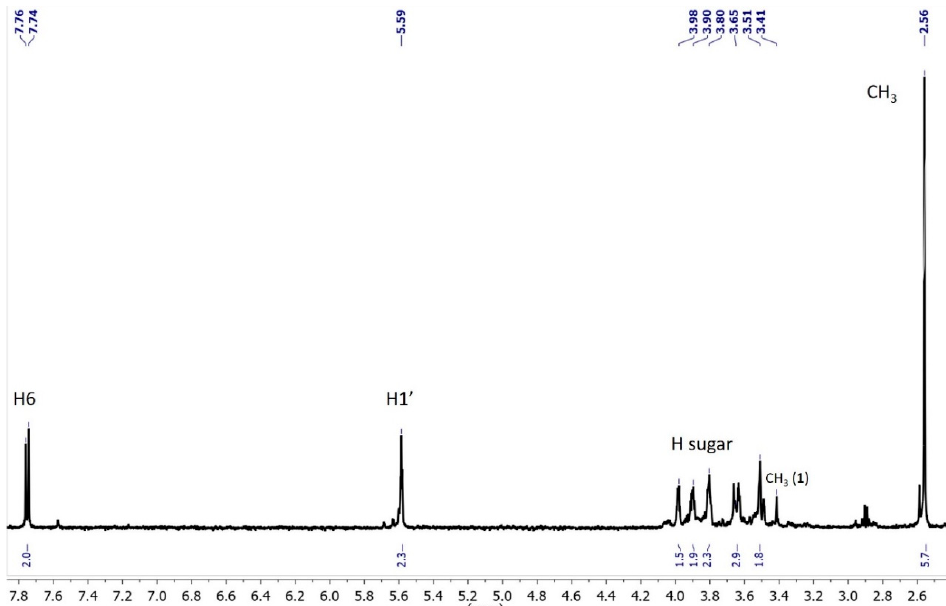
Figure 7. 1 H-NMR (600 MHz, 278 K) spectrum of irradiated 1 in D 2 O. The tube contains 90% of oxaziridines 3 and 4 in a 50:50 ratio and 10% of 1. The solvent peak at δ 4.7 ppm is suppressed. NOE experiment on the 3 + 4 mixture showed a correlation between the H6 protons ( δ 7.76